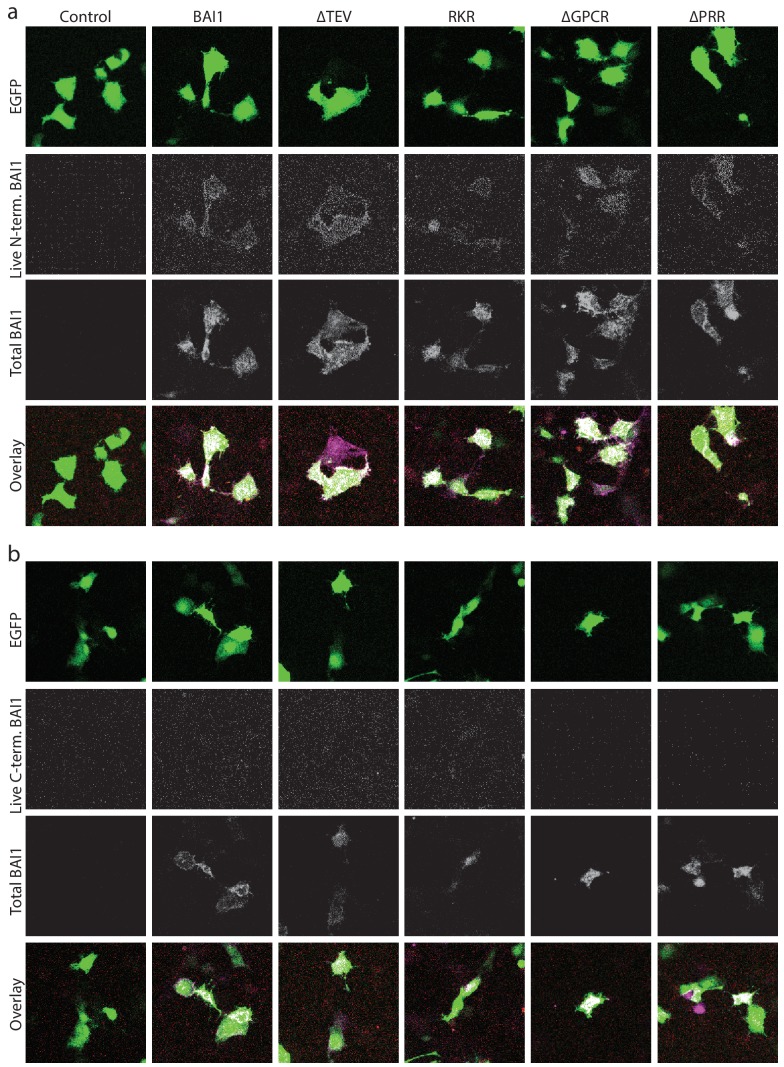
Surface labeling of BAI1 and mutants.(a) Representative images of Cos-7 cells expressing EGFP and empty vector (Control), wild-type BAI1 (BAI1) or the indicated BAI1 mutants live surface labeled using a polyclonal antibody against an extracellular N-terminal epitope on BAI1, then washed, fixed, permeabilized and labeled with an antibody against the intracellular C-terminal tail of BAI1. Shown are the EGFP expression, N-terminal labeling (live, N-terminal), total BAI1 labeling (permeabilized, C-terminal), and an overlay of all of these signals. (b) Representative images of an experiment identical to that in panel a, but live labeled with the C-terminal antibody instead of the N-terminal antibody. The ∆N-term. mutant was not amenable to this analysis because it does not contain the N-terminal epitope. However, we previously demonstrated that this mutant is surface localized using an N-terminal flag-tag (Tu et al., 2018). All experiments were repeated three independent times with similar results.